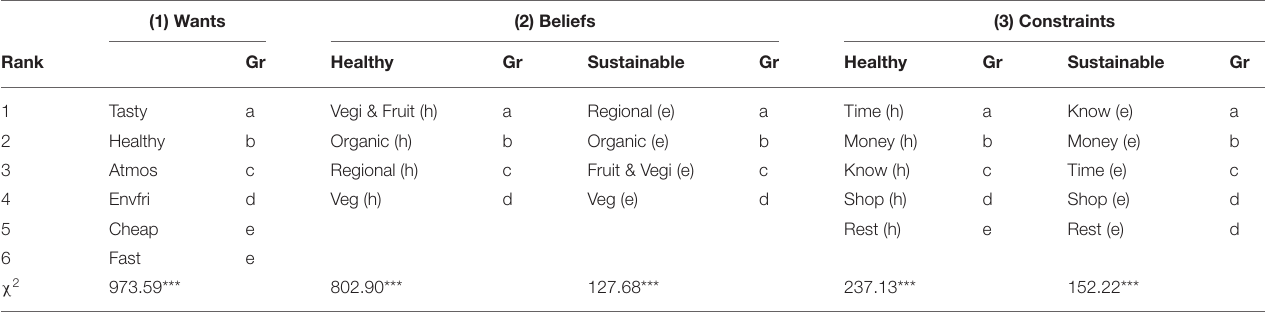
TABLE 3 | Non-parametric tests for identifying priorities in wants, beliefs and perceived constraints related to food choices and particular for healthy and environmentally sustainable eating for the beliefs and constraints. (1) Wants (2) Beliefs (3) Constraints Rank Gr